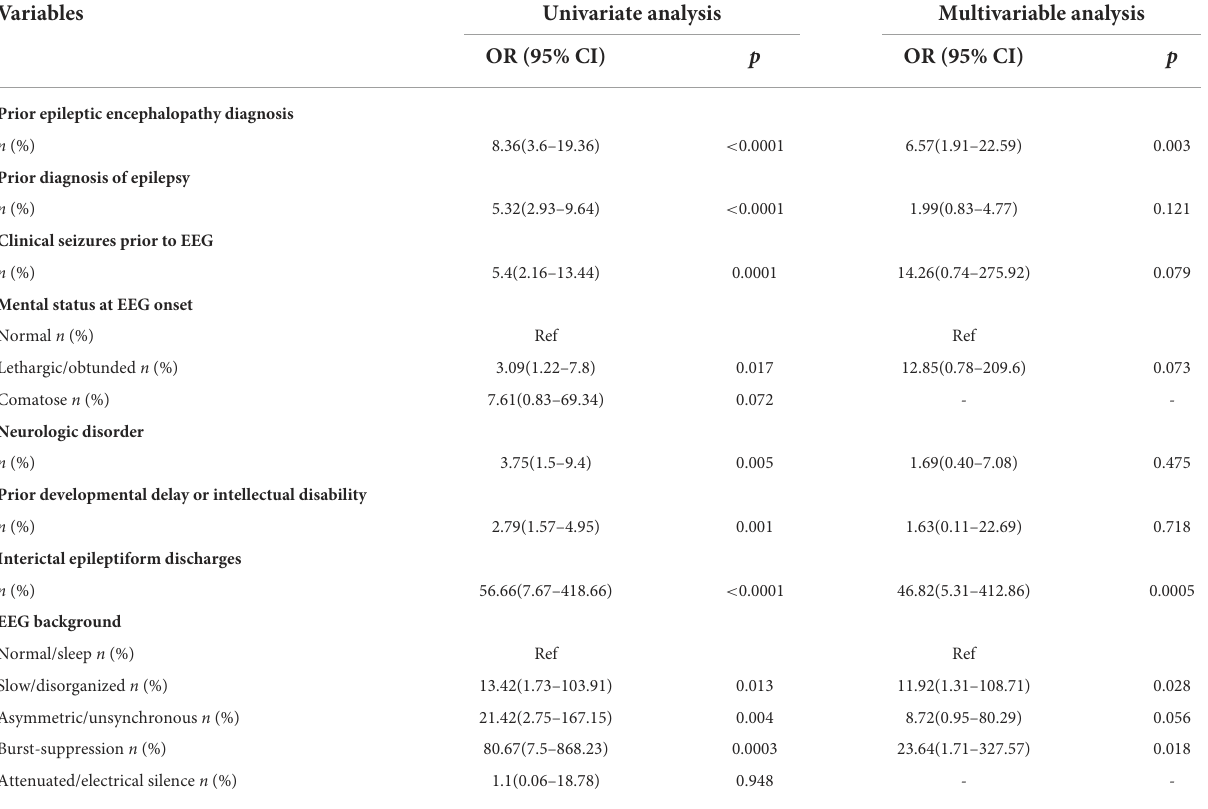
TABLE 4 Risk factors for electrographic seizures.